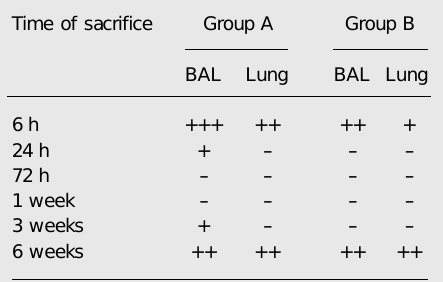
Figure 1. Number of cells pres- ent in the bronchoalveolar lav- age of Swiss mice infected with Mycobacterium avium and treated with thalidomide (black columns) or not (stippled col- umns). Values are reported as median number of cells.